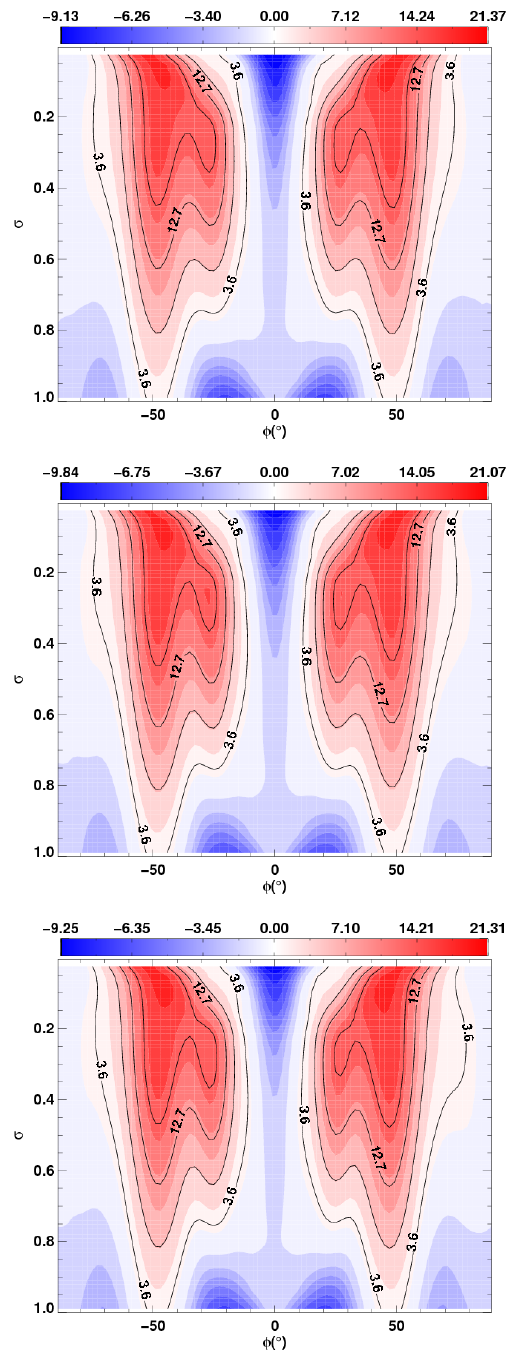
Figure 9. Figures showing, for the Earth-like test (Menou and Rauscher, 2009), the zonally and temporally averaged zonal wind Fig. 9. Figures showing, for the Earth–Like test (Menou and fields for the different EG models. Top panel: EG, middle panel: Rauscher, 2009), the zonally and temporally averaged zonal wind EG gc , and bottom panel: EG sh (see Table 2 for explanation of model fields for the different EG models. Top panel: , EG, middle panel: , EG gc and bottom panel: , EG sh (see Table 2 for explanation of model types).